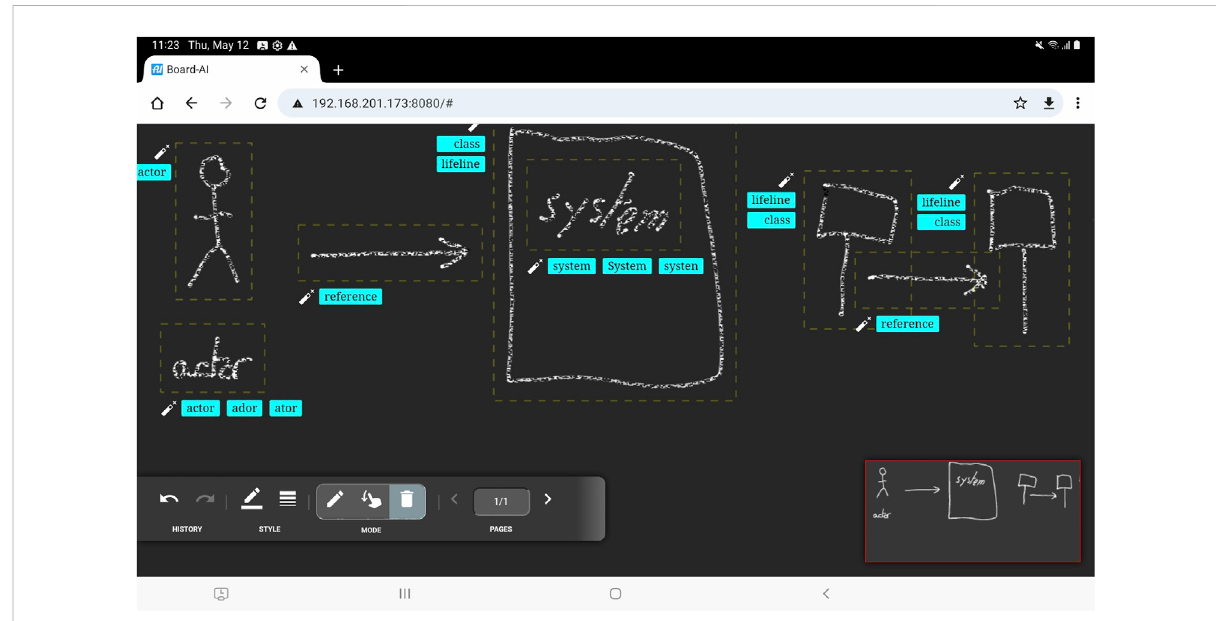
FIGURE 4 Screenshot of the BOARD-AI interface running on a Samsung Galaxy S6 Lite. Its minimalist interface features a wide area to sketch model elements, a collapsible toolbar, and an outline. Blue bubbles along with drawn sketches provide hints about the model elements to recognize.